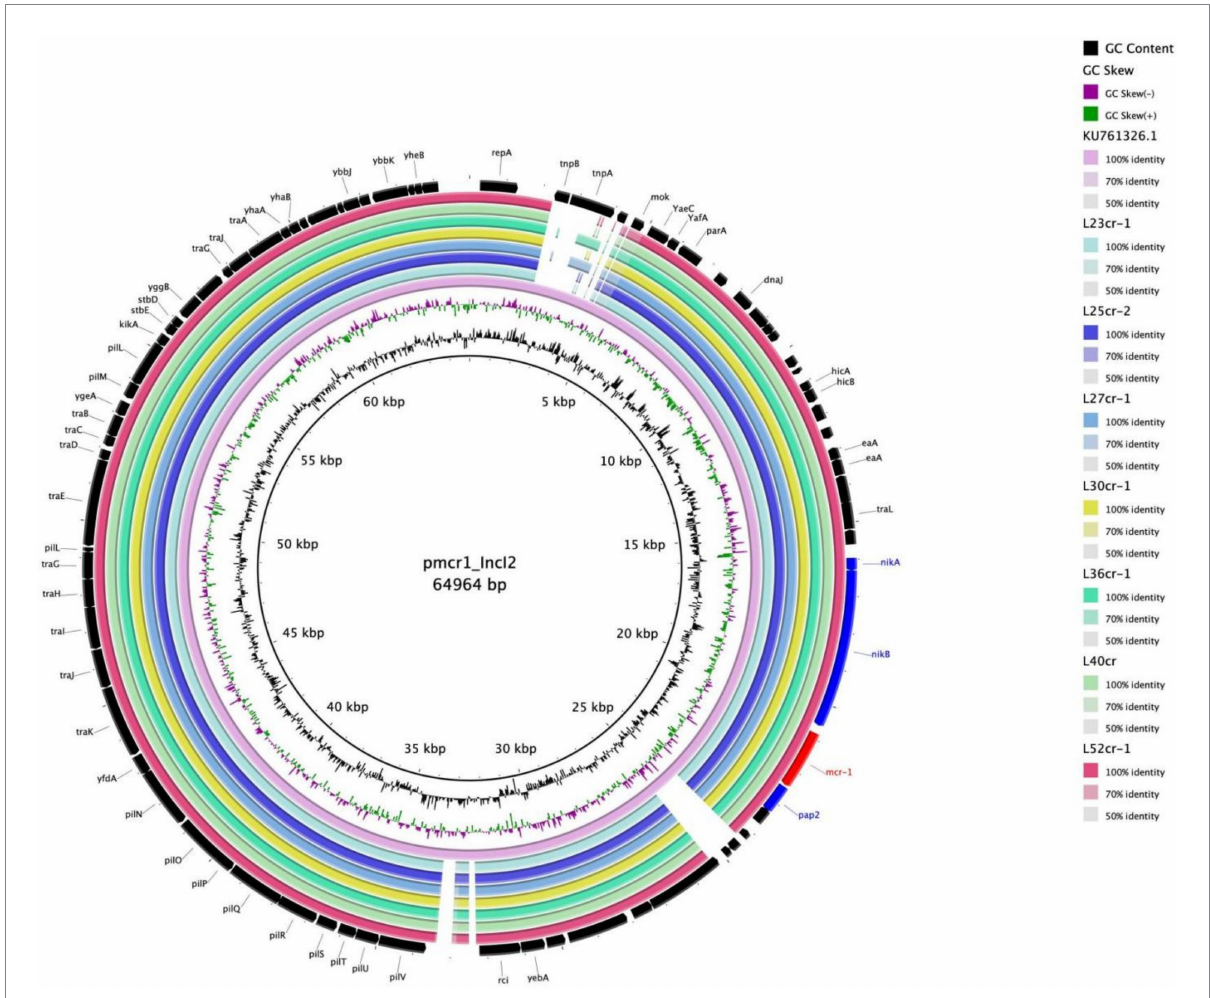
FIGURE 2 Multiple circular sequence alignments of reference plasmids with homologous overlapping strain groups identified in this study. The ring represents the corresponding plasmids shown in the legend. The reference plasmid is pmcr1_IncI2 (GenBank accession number: